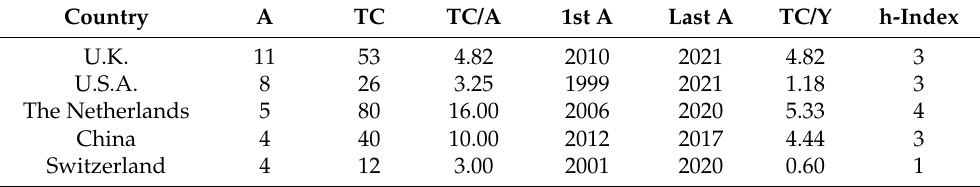
Figure 11. Worldwide publications on pension research in the Mathematics area. Source: own elaboration. Table 13. The top 5 most productive countries on pension research in the Mathematics area.